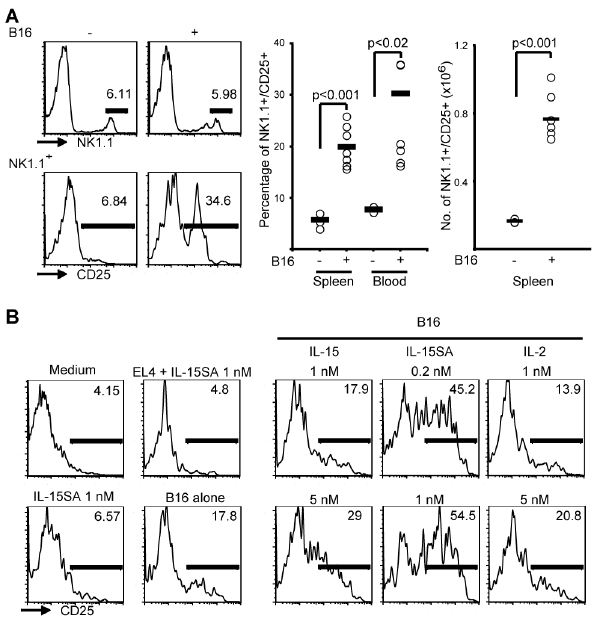
Figure 1. Activation of NK cells after exposure to B16 is supported by IL-15. A. Mice were injected with B16 tumor cells, and the activation status of NK cells was assessed 21 days later. An example (left) shows that while little effect was seen on the percentage of NK1.1 + cells among PBMCs (upper panels), a high percentage of NK1.1 + cells expressed CD25 only in the presence of tumors (lower). Both the percentage of NK1.1 + /CD25 + cells among splenocytes and PBMCs (middle) and their total numbers in spleens (right) were increased by the presence of B16 tumors. B. IL-15 supports NK cell activation. One million freshly isolated murine NK cells were cultured in medium, in 1 nM IL-15SA, or were co-cultured with equal numbers of NK-insensitive EL-4 control cells or NK-sensitive B16 cells. Analyzing CD25 among NK1.1 + cells 6 h later showed that co-incubation with B16 but not with EL-4 had caused the activation of a small percentage of NK cells. While the presence of 5 nM IL-15 and of 0.2 or 1 nM IL-15SA in B16 co- incubation cultures strongly increased this percentage compared with B16 alone at left, IL-2 was only marginally active. Data were reproducible in at least three independent